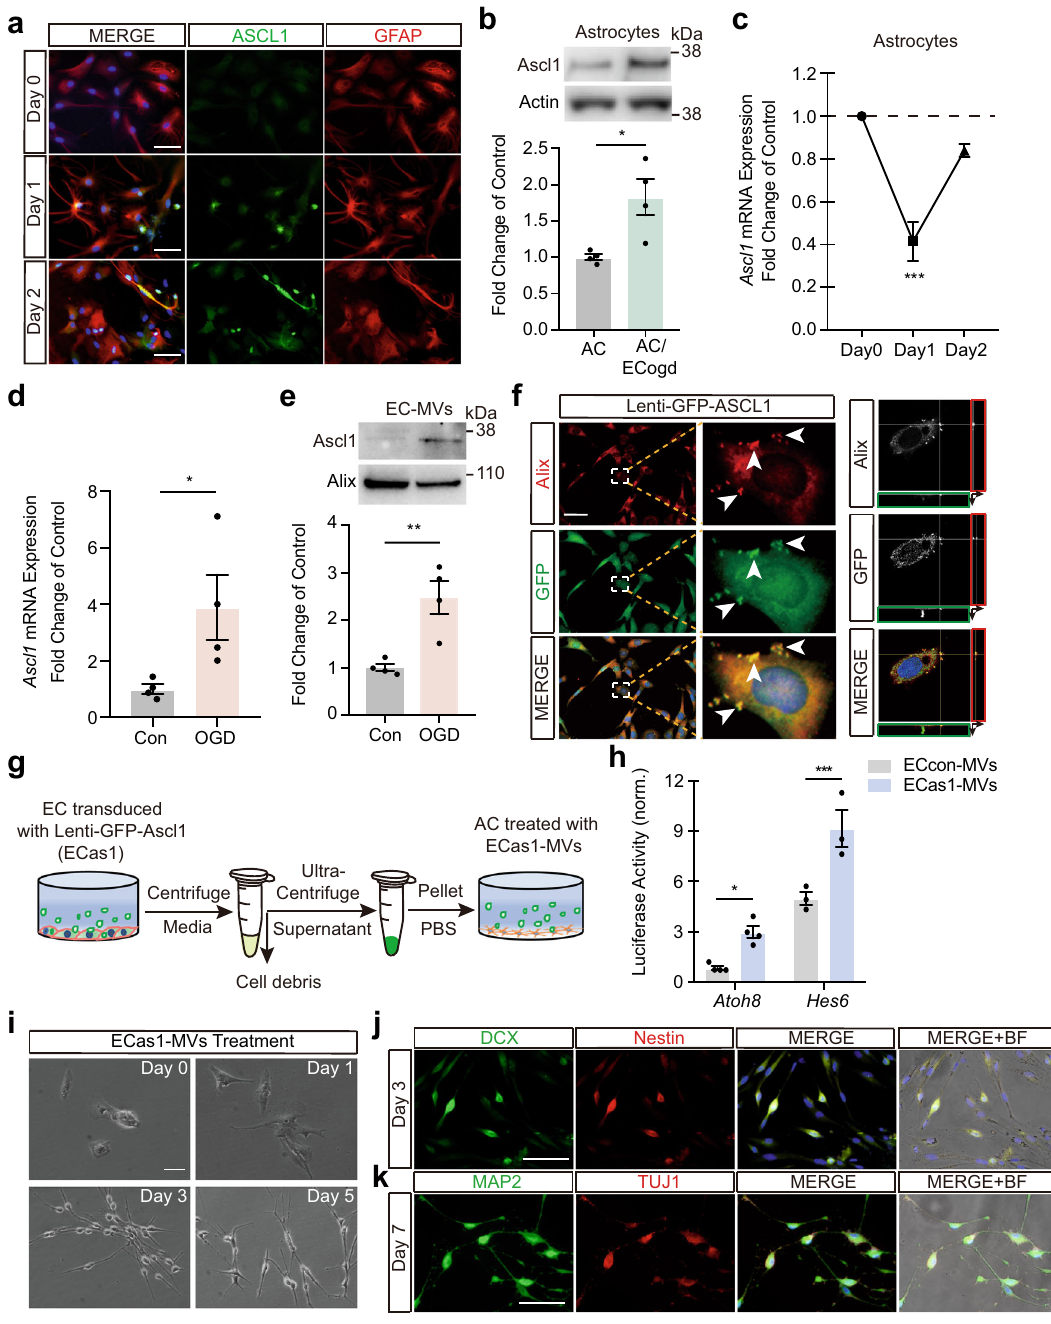
Fig. 3 | Brain endothelial cells-derived microvesicles containing pro-neural transcription factor Ascl1 initiate astrocytes trans-differentiation. a Representative immunostaining of Ascl1 and GFAP at day 0, day 1 and day 2 post AC co-cultured with OGD-stimulated brain endothelial cells. b Protein levels of Ascl1 in AC or AC at day 2 post co-cultured with OGD-stimulated brain endothelial cells (ECogd); n =4 biologicallyindependent samples; p =0.0173. c mRNAlevelsof Ascl1 in AC at day 0, day 1 and day 2 post co-cultured with OGD-stimulated brain endothelialcells; n =3biologicallyindependentsamples; p <0.0001. d mRNAlevels of Ascl1 in normal or OGD-stimulated brain endothelial cells; n =4 biologically independent samples; p =0.0471. e Protein levels of Ascl1 in MVs derived from normal or OGD-stimulated brain endothelial cells; n =4 biologically independent samples; p =0.0065. f Confocal microscopy revealed co-localization of GFP and Alix in brain endothelial cells transduced with GFP-Ascl1 lentivirus. g Experimental